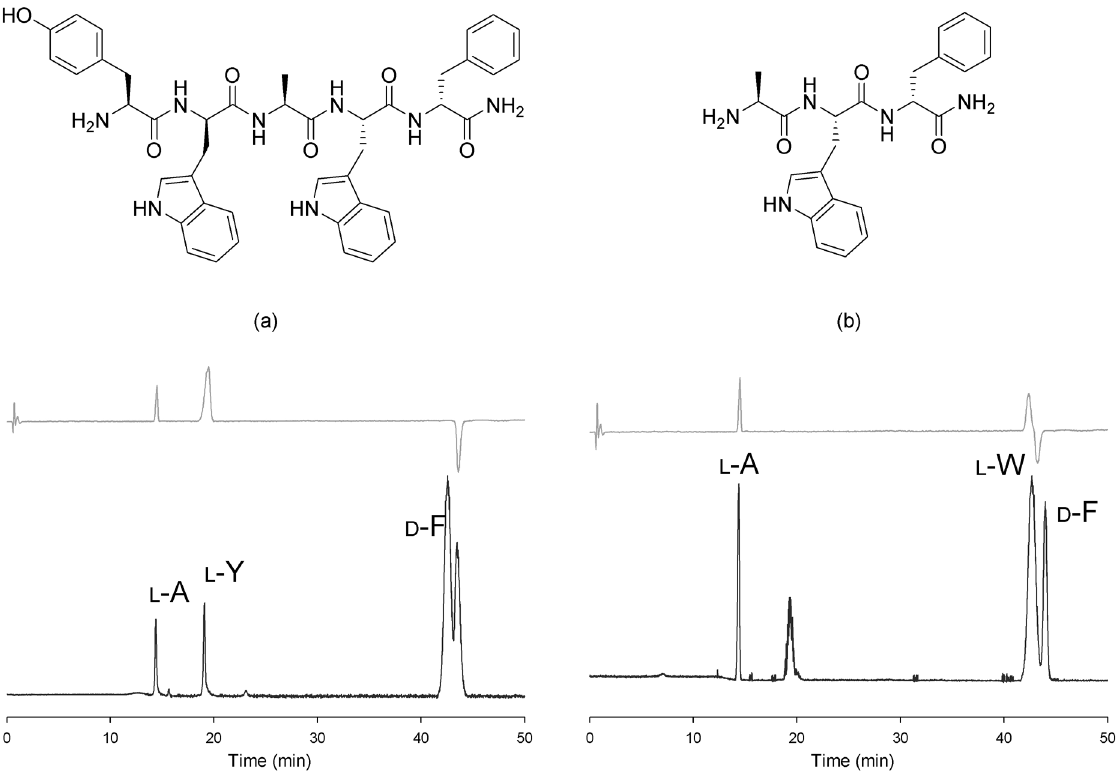
Figure 5. Ion chromatogram (lower) and CD absorption chromatogram (upper) of the PTH derivatives of acid hydrolysates of ( a ) the commercial pentapeptide l-Tyr-d-Trp-l-Ala-l-Trp-d-Phe and ( b ) the residual peptide l-Ala-l-Trp-d-Phe after elimination of l-Tyr and d-Trp by Edman reactions. The unit of CD absorption is